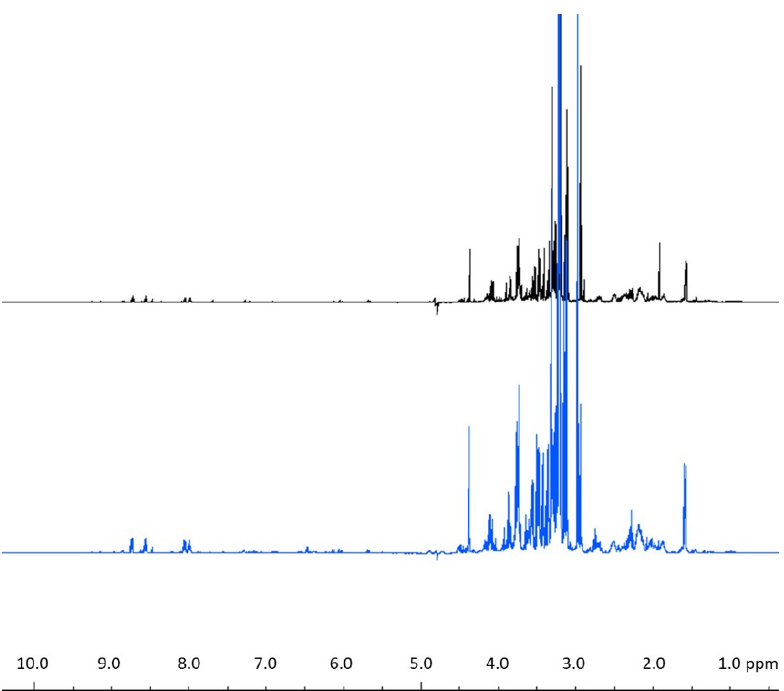
Figure 6. Representative 1 H NMR spectrum of Porites compressa obtained using the recommended workflow from the current study (black) compared to a representative 1 H NMR spectrum of P. compressa from the literature (blue) [35]. Spectra are normalized to chemical shift standard 3-trimethylsilylpropionic-2,2,3,3-d acid sodium salt (TMSP) at 0.0 ppm.